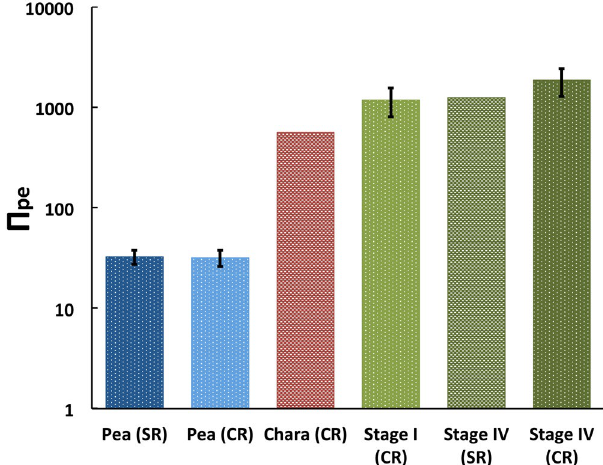
Figure 1. A comparison of the Π pe values calculated for growing cells of pea stems (Pea) 10 , growing internode cells of C. coralline (Chara) 11, 12 , and growing sporangiophores of P. blakesleeanus (Stage I and Stage IV) 4, 6 . Note that the vertical scale for Π pe is logarithmic. Also compared are the values obtained from in vivo stress relaxation (SR) and in vivo creep (CR) experiments for pea cells and stage IV sporangiophores. Only the in vivo creep experiments conducted on Stage I (CR) and Stage IV (CR) sporangiophores used intact cells (growing on the mycelium). The confidence intervals represent the maximum and minimum values of Π pe that can be calculated from the statistical data (standard deviation and standard errors) presented in the respective papers 4, 6, 10 (see Calculations, Estimates, and Methods for